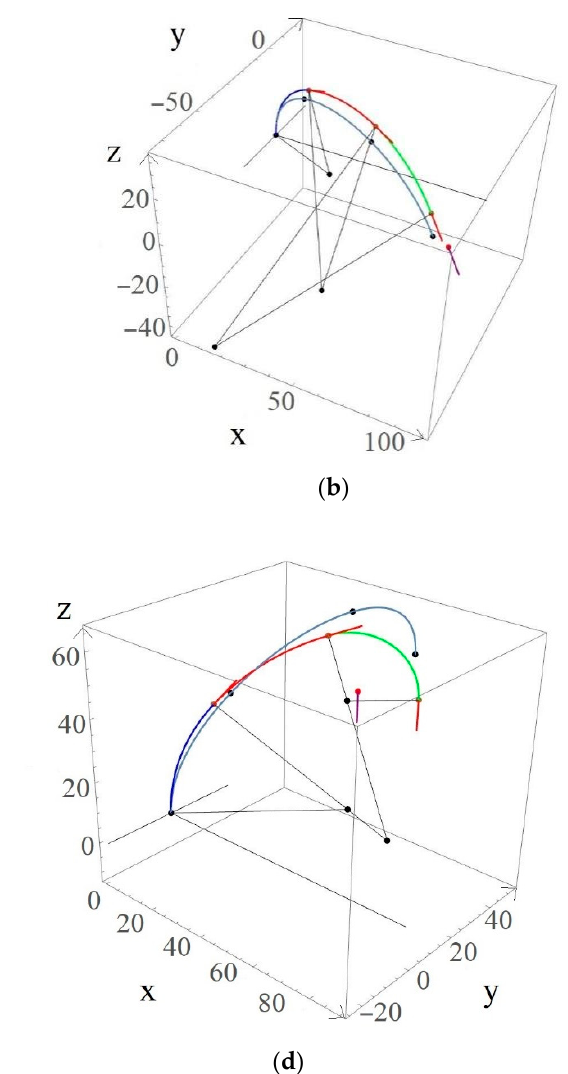
curves are in blue, red, and green: ( a ) robot spine view when (cid:1833) = (50, 0,63) and (cid:1815)(cid:3549) (cid:2928) = (0.254, −0.889,0.381) ; ( b ) robot